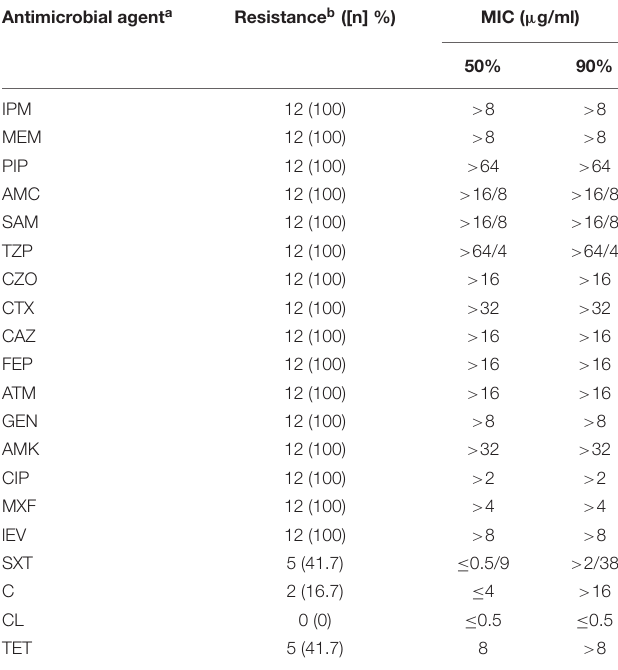
TABLE 2 | Susceptibility of the 12 isolates against different antimicrobial